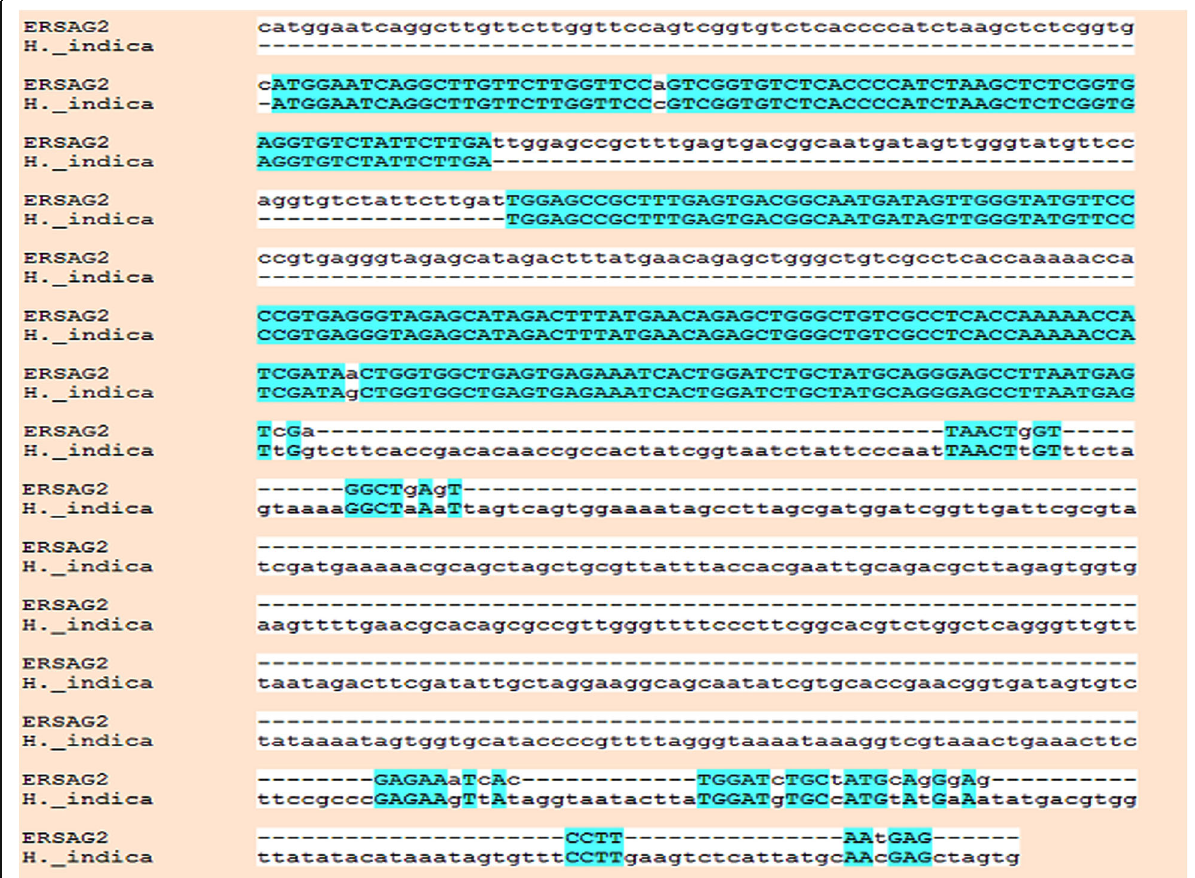
Fig. 3 Alignment of ITS1 sequences from Heterorhabditis indica Aborawash and ERSAG2. Identical positions are shadowed